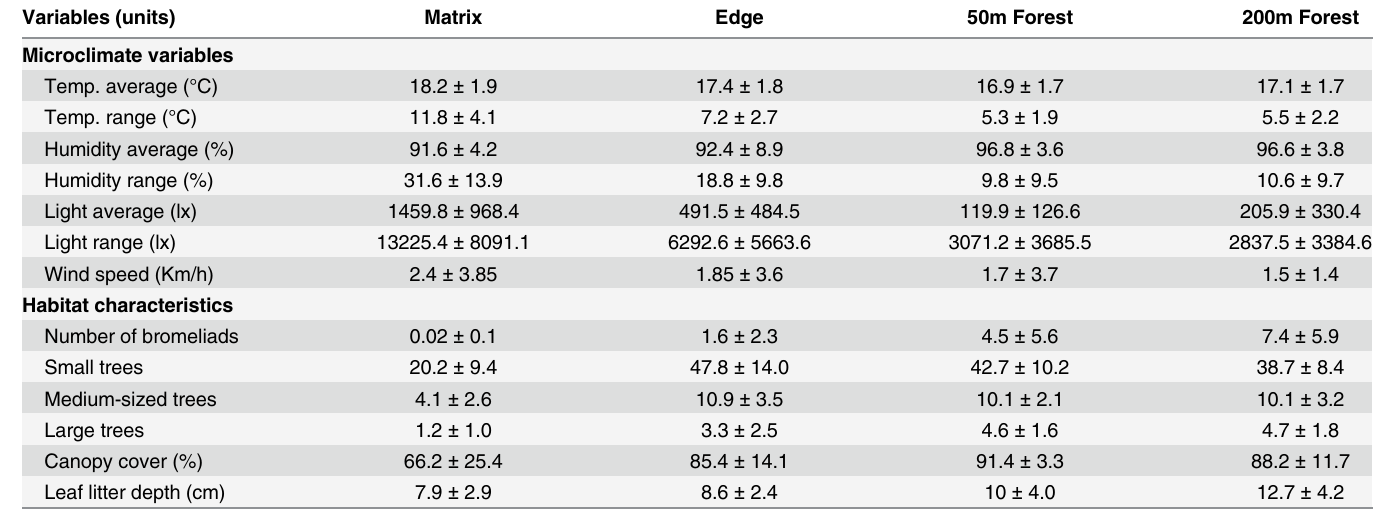
Table 3. Microclimate variables and habitat characteristics. Measurements conducted by 'Distance' across 21 sites. Values are mean ± standard deviation.